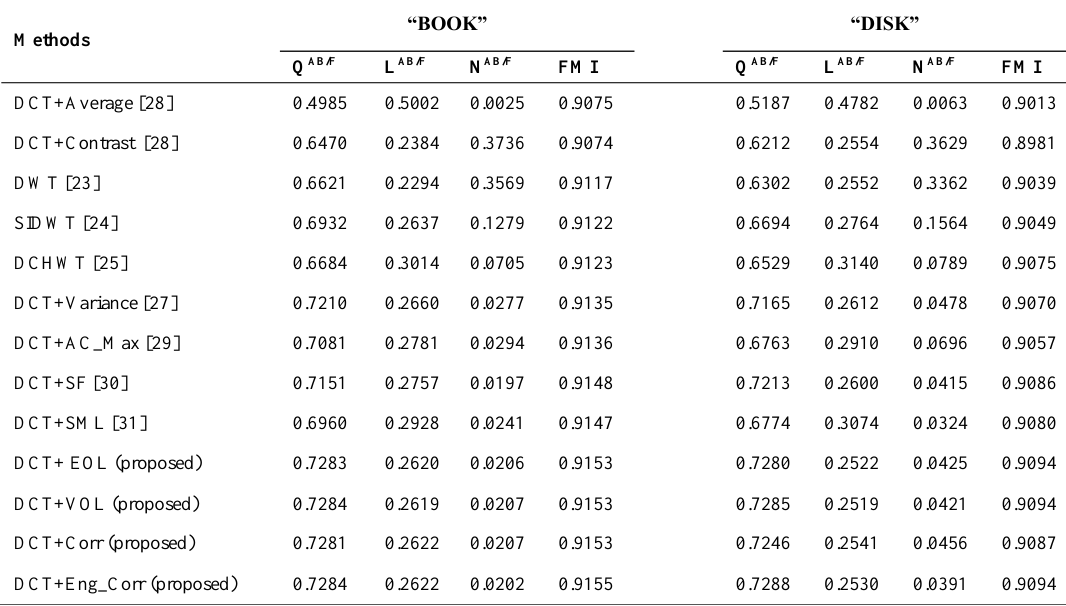
Table 2. Q AB/F , L AB/F , N AB/F , and FMI comparison of various image fusion methods on non-referenced images.